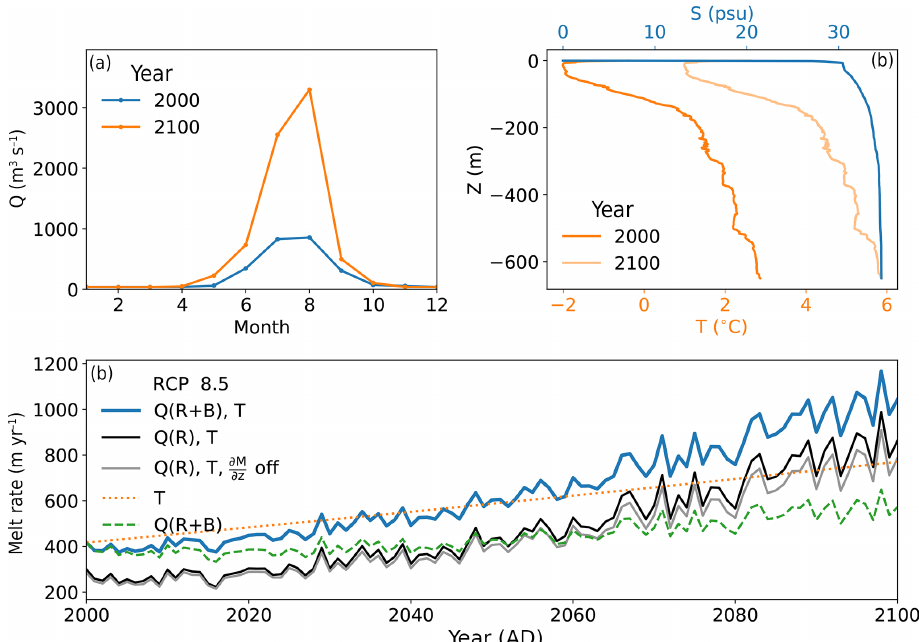
Figure 12. (a) Monthly subglacial discharge derived from runoff and basal melt ( R + B ) for Helheim Glacier and the scenario RCP 8.5 in the years 2000 and 2100. (b) Temperature–depth and salinity–depth profiles obtained from measurements for the years 2000 and 2100. The corresponding submarine melt rates are depicted in panel (c) . The effects of increased temperature and discharge only (orange dotted and green dashed lines, respectively), as well as the combined effect (solid lines) are displayed until the year 2100. Melt rates with subglacial dis- charge from solely surface runoff are depicted in black. Melt rates of subglacial discharge containing only surface runoff that was calculated without the surface elevation feedback are depicted in grey.